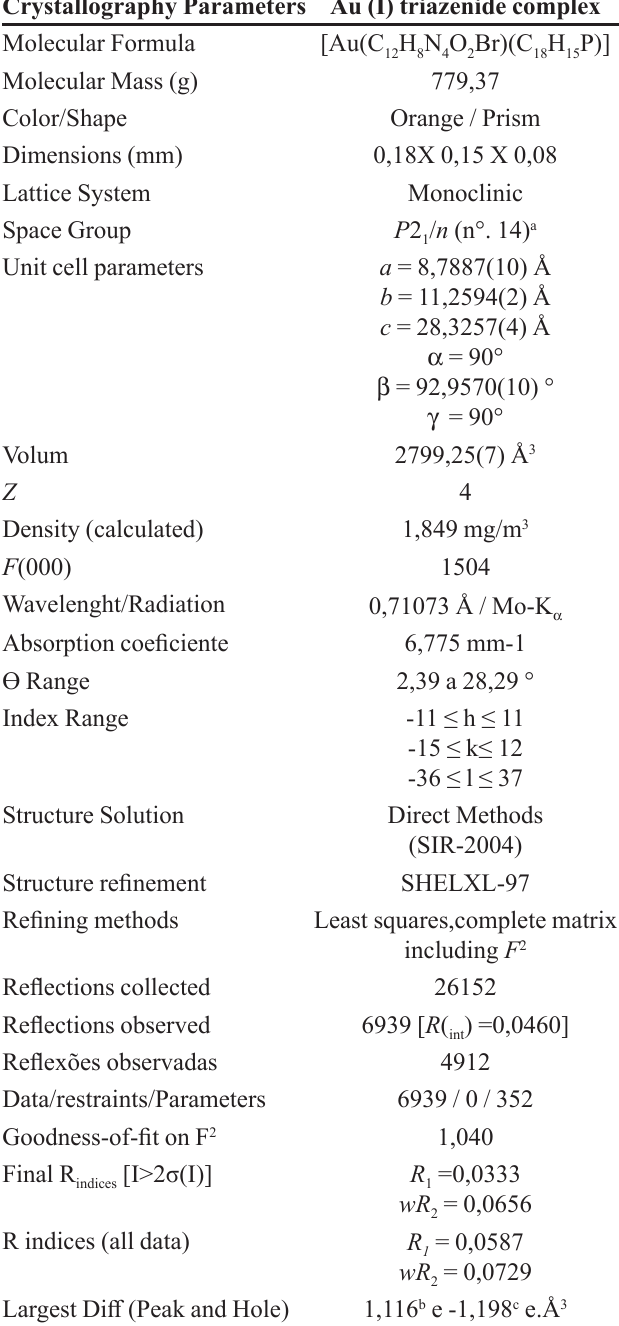
TABLE I - Data from intensity collection and refinement of the crystal/molecular structure of the Au (I) triazenide complex Crystallography Parameters Au (I) triazenide complex